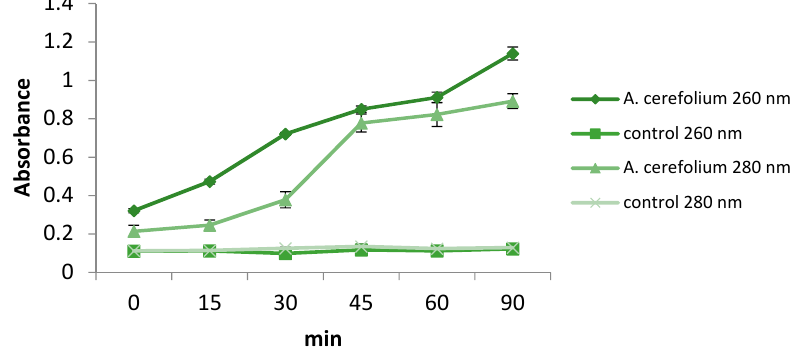
Figure 5. Leakage of cellular components in C. albicans measured at 260 nm and 280 nm.